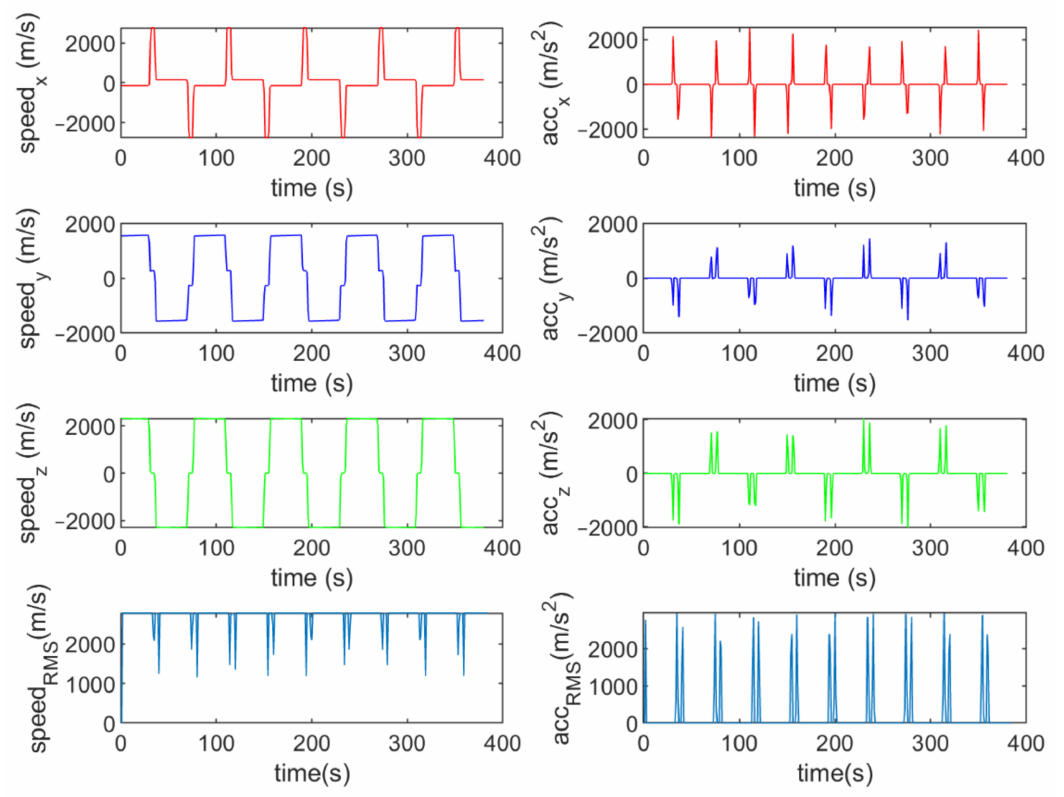
Figure 14. The speed and acceleration components in the fifth scenario.